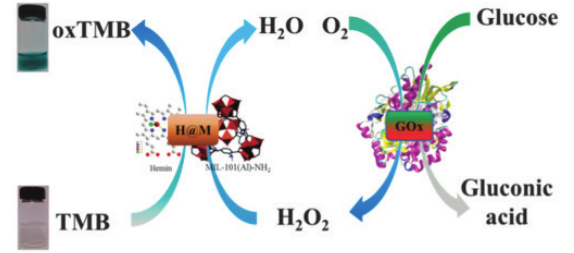
Scheme 9: Schematic illustration of colorimetric determination of glucose using glucose oxidase (GOx) and haemin@MIL-101(Al)-NH hybrid material -catalyszed reactions [118]. Reprinted with permission from Ref. [118]. Copyright © 2013, Royal Society of